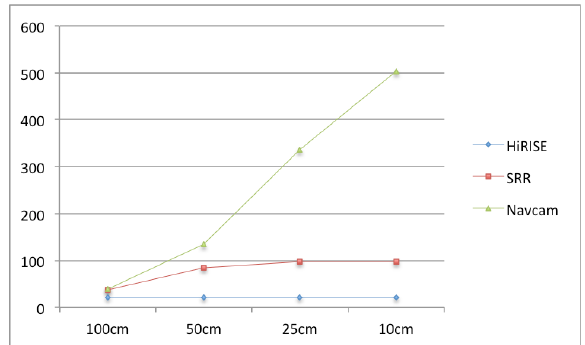
Figure 17 Rock frequency-size distribution for HiRISE, SRR and Navcam at MSL Sol 520.